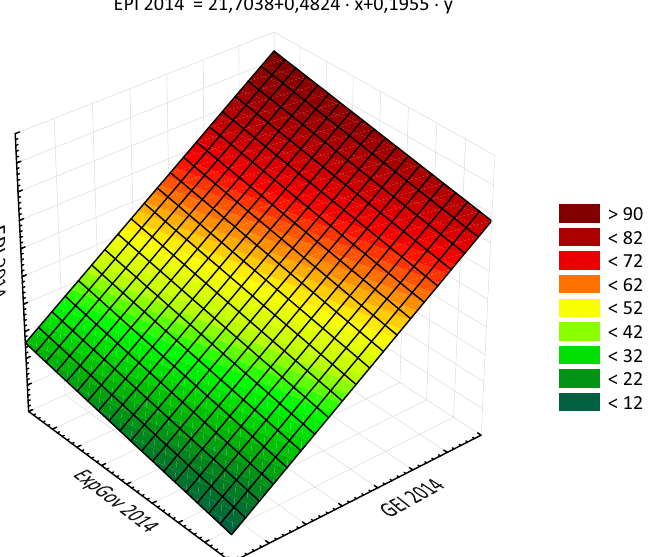
Figure 3. Schedule of multiple linear regression model of dependence of country environmental state on the level of government expenditures in GDP and government